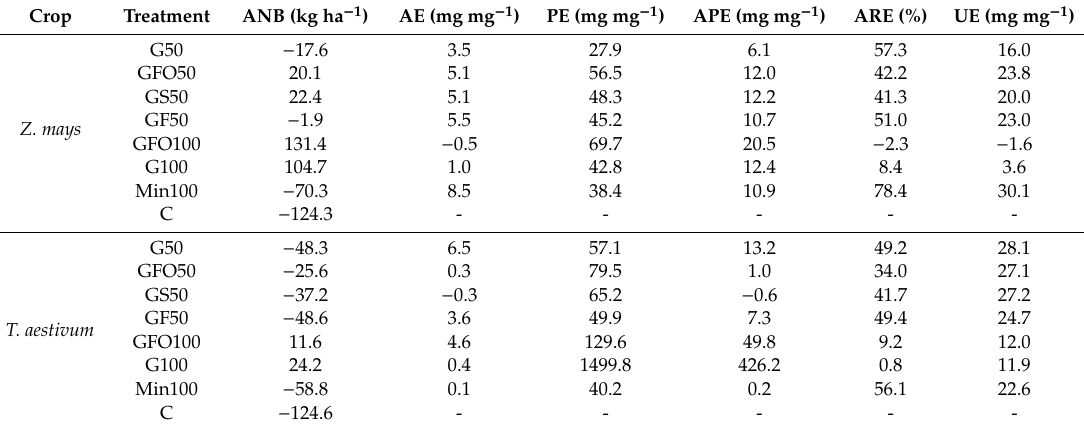
Table 6. Apparent nitrogen balance (ANB), agronomic e ffi ciency (AE), physiological e ffi ciency (PE), agro-physiological e ffi ciency (APE), apparent recovery e ffi ciency (ARE), and utilization e ffi ciency (UE) indexes were calculated for the di ff erent crops and for the entire crop